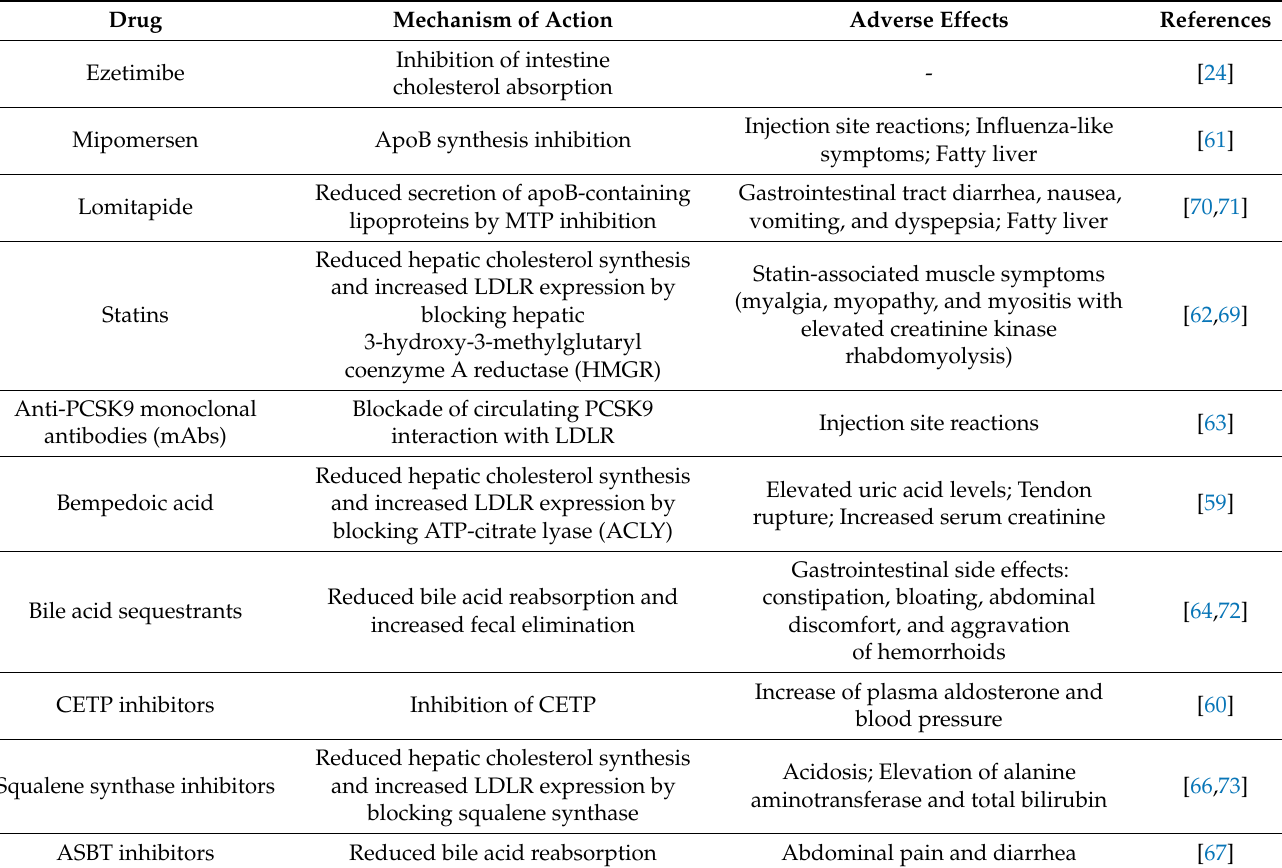
Table 1. Current strategies for lowering the LDL-C